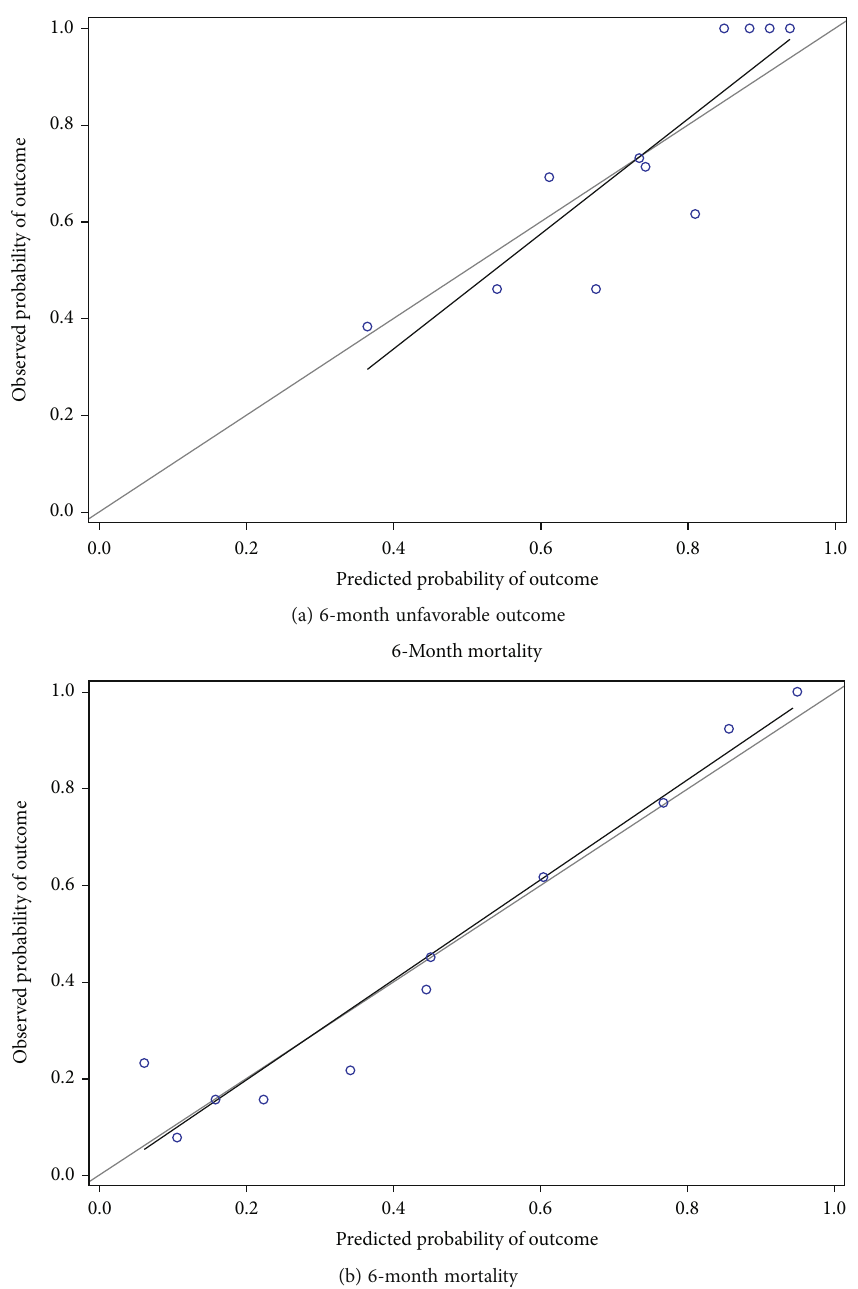
Figure 2: Calibration plots for 6-month adverse outcomes and mortality in the IMPACT core model. (a) Calibration plot of IMPACT Core+FIB to predict 6-month unfavorable outcome. (b) Calibration plot of IMPACT Core+APTT to predict 6-month